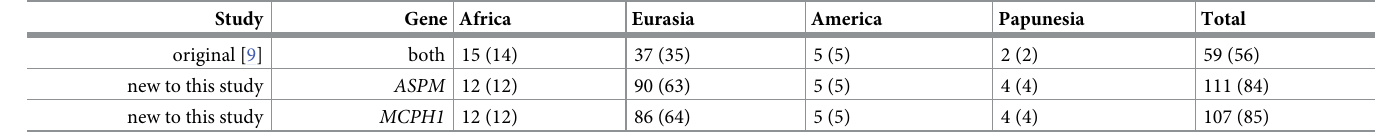
Table 3. The original genetic samples and (meta)populations (in parentheses) used in [9], and the new ones added in this study, by